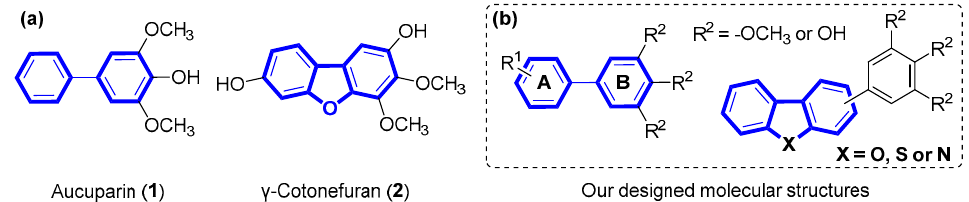
Figure 1. ( a ) Typical chemical structures of natural biphenyls and dibenzofurans phytoalexins and ( b ) our designed molecular structures.